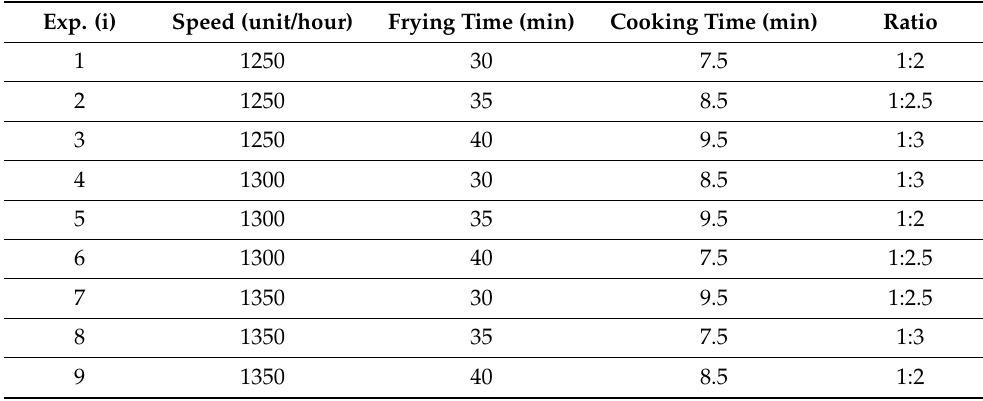
Table 4. Responses for the first run, based on Taguchi L9.